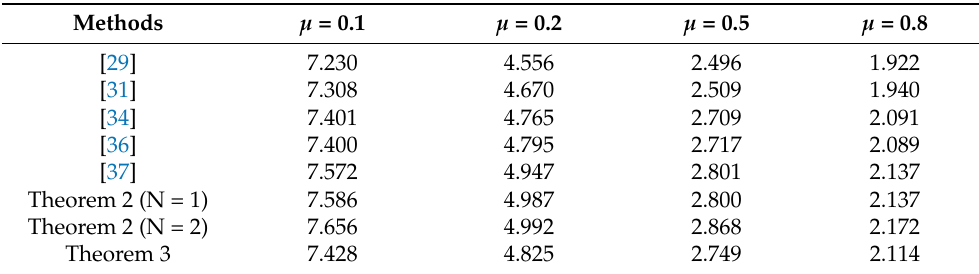
Table 2. Maximum allowable upper bounds of (cid:101) h for different µ